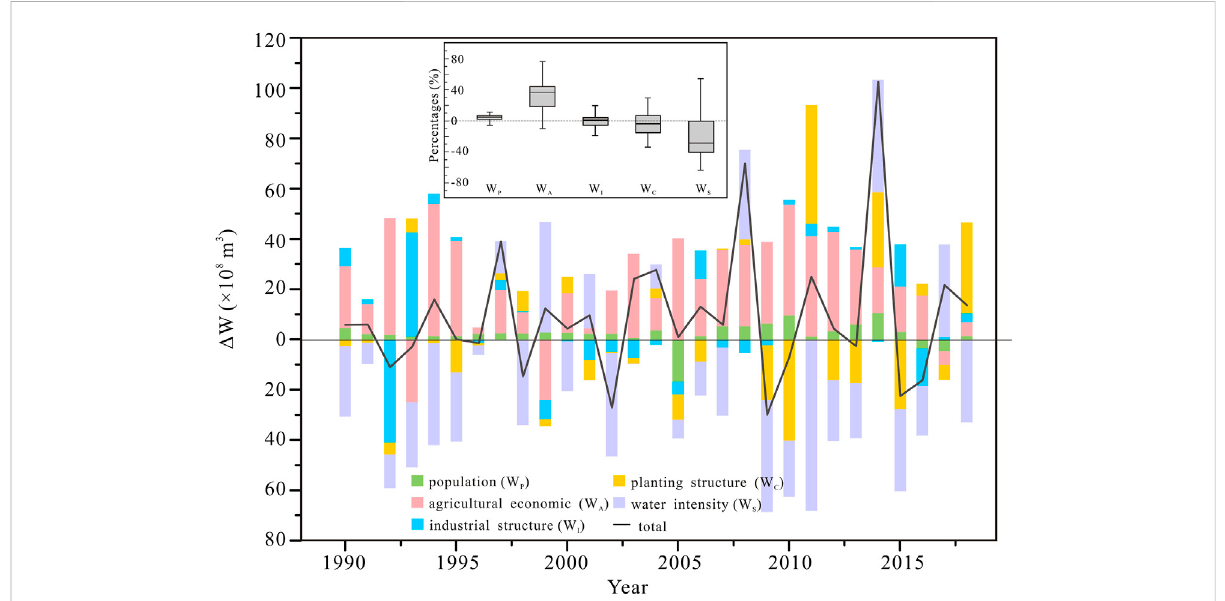
FIGURE 9 Contributions of driving factors to changes in agriculture water use in Xinjiang from1989 to 2018.